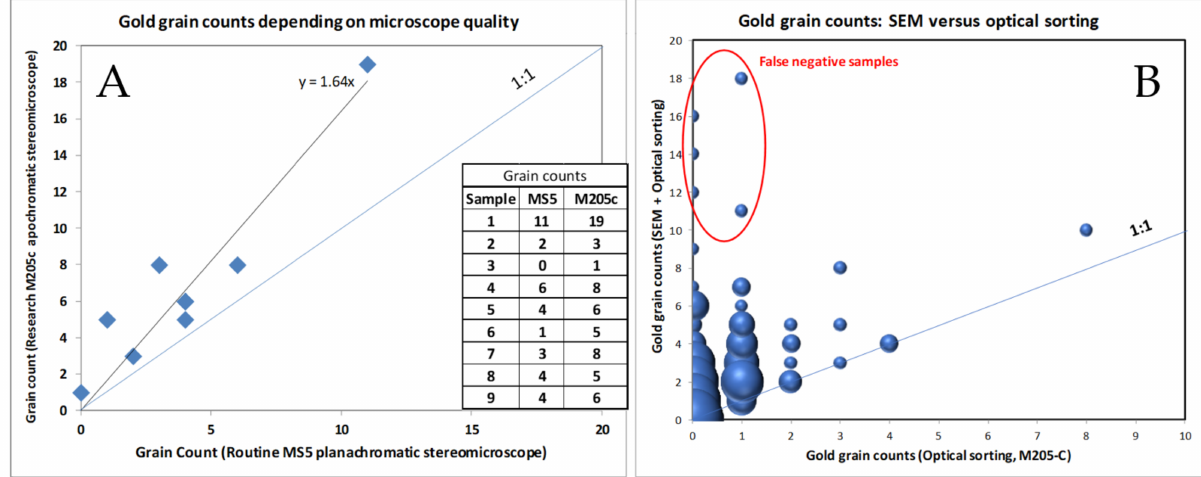
Figure 5. ( A ) Results of a test where the same series of concentrates were sorted for gold grain under a routine Leica MS5 stereomicroscope and a research grade Leica M205c stereomicroscope by experienced mineralogists. ( B ) Results of a test on 134 samples that were sorted visually with a research grade Leica M205C stereomicroscope and reprocessed with SEM scanning. Only 20% of the grains were noted by visual sorting, and 5 out of 6 anomalous samples were missed. The bubble size refers to the number of samples (1 to 23) with a specific